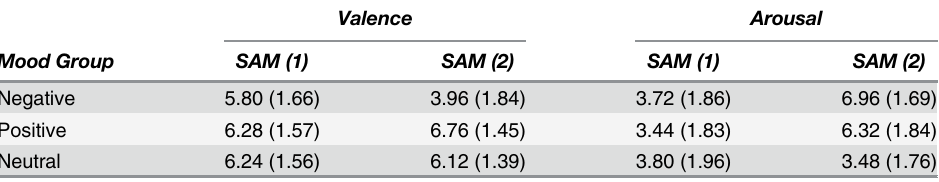
Table 1. Mean valence and arousal ratings before (1) and after (2) mood